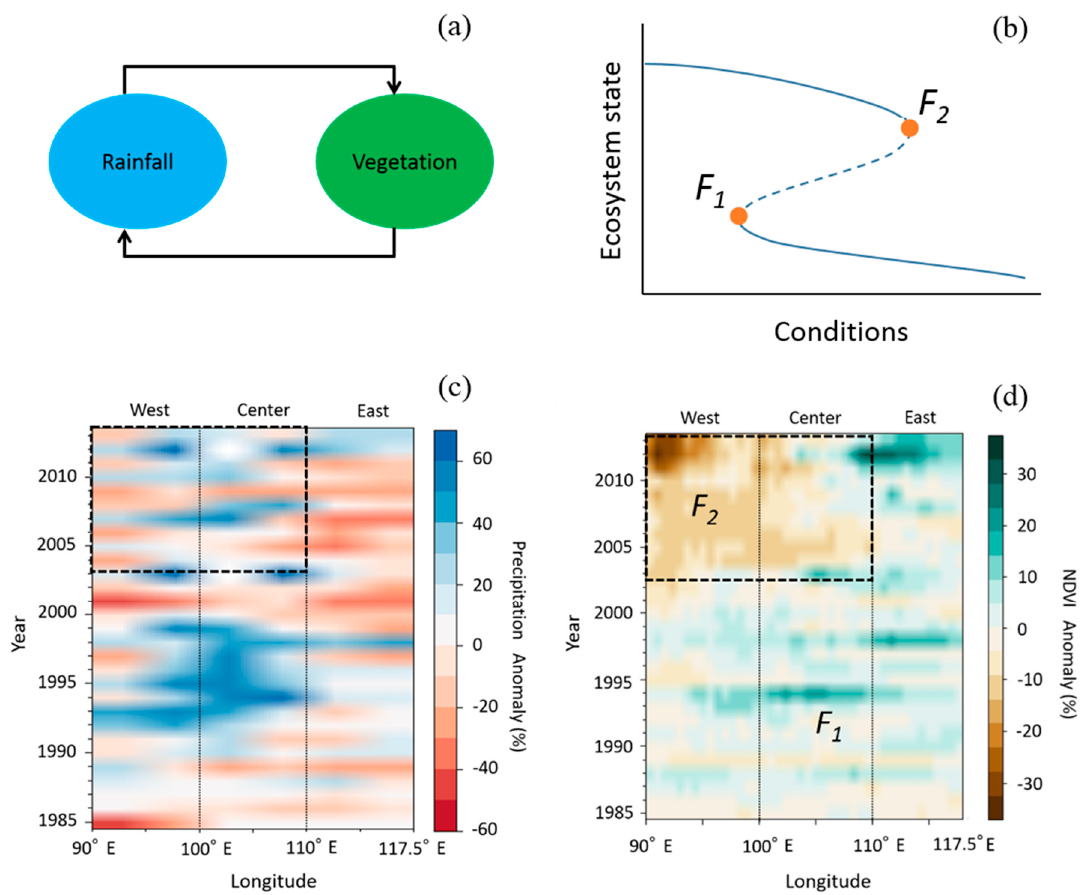
Figure 10. Environmental regime shifting in North China during 2003–2013. ( a ) shows that the concept of relationship between precipitation and vegetation. And ( b ) shows that the concept of regime shift. ( c , d ) are enhanced the difference Figure 3 (Hovmoller diagrams: where, ( c ) precipitation anomaly and ( d ) NDVI anomaly for the study area).